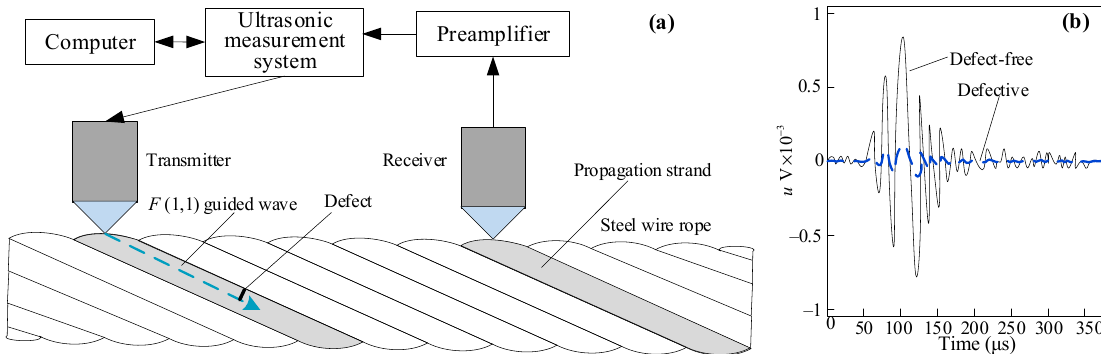
Figure 4. Non-destructive testing principle of steel wire rope by ultrasonic guided wave method [52]. ( a ) Detection system schematic diagram; ( b ) sketch map for waveforms of defect-free and defective signal.